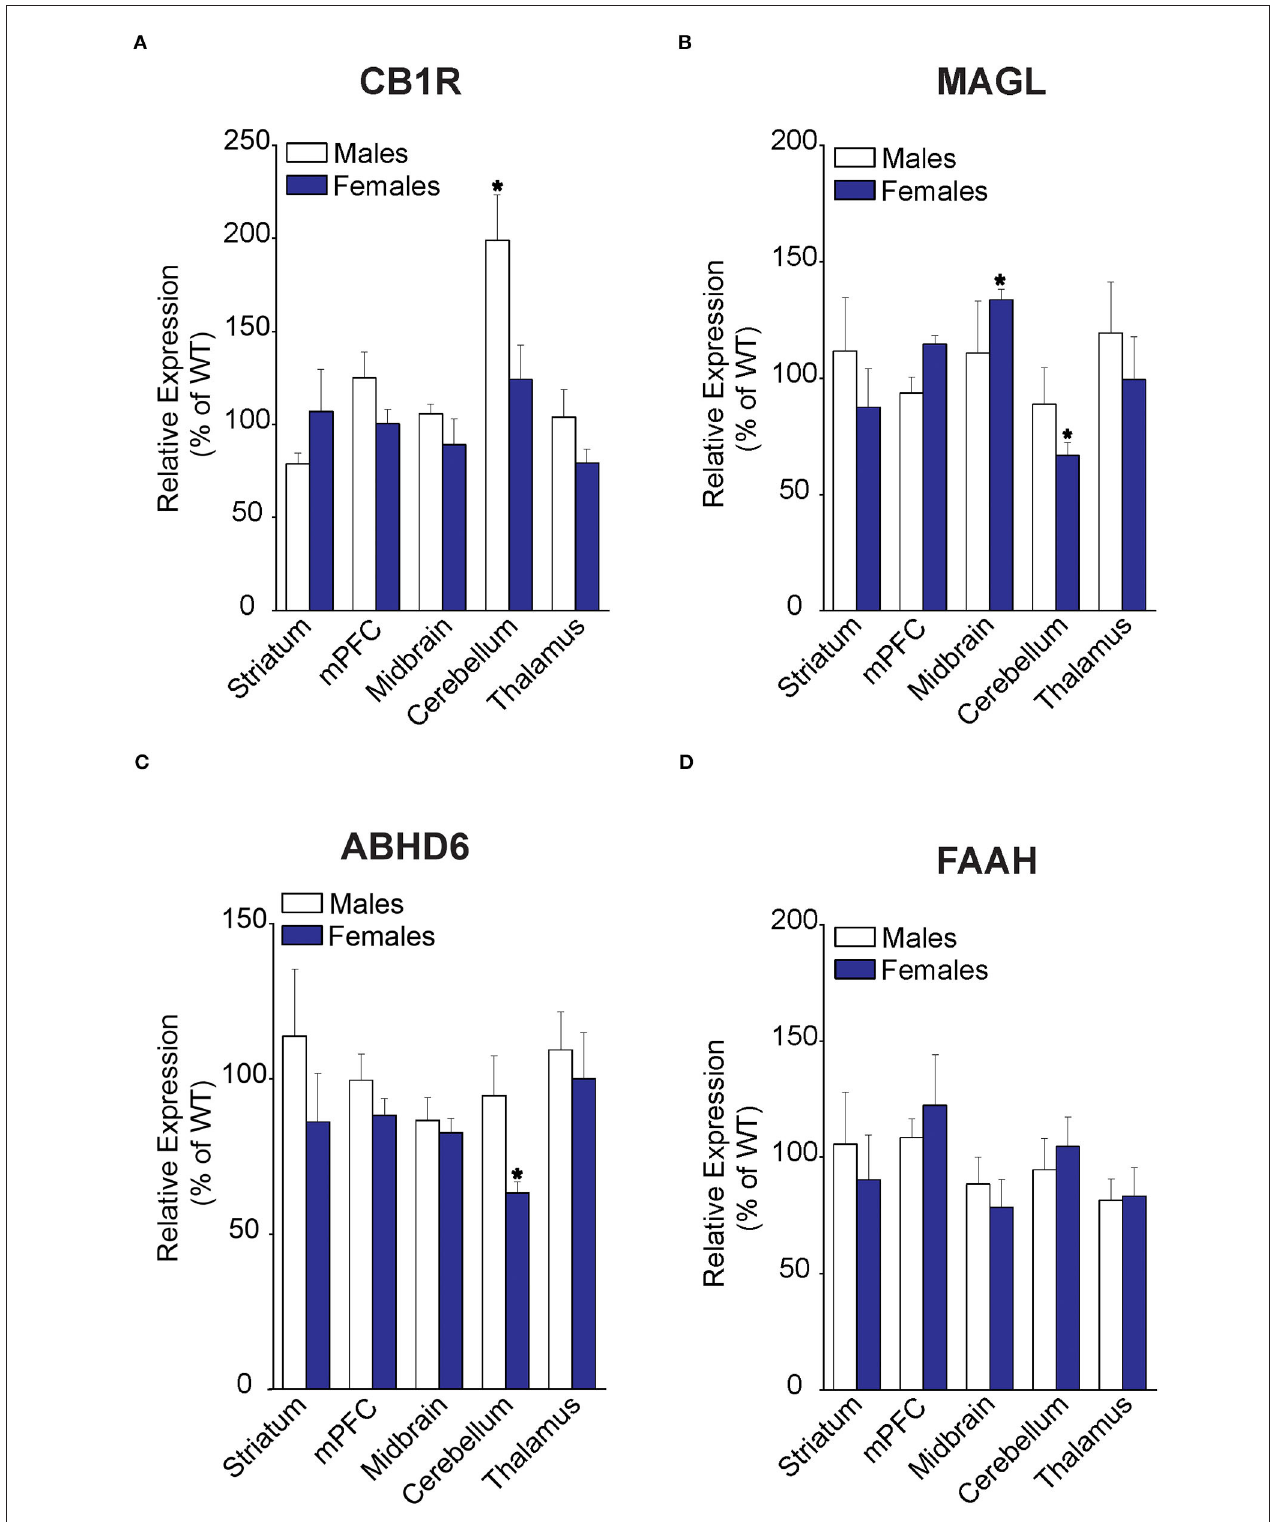
FIGURE 4 | Relative expression of 2-AG and AEA catabolic enzymes in brain regions of WT and FABP5 KO mice. (A–D) Relative expression of CB1R, MAGL, ABHD6, and FAAH in male and female FABP5 KO mice compared to WT controls ( n = 5). *, p < 0.05; KO vs. WT.